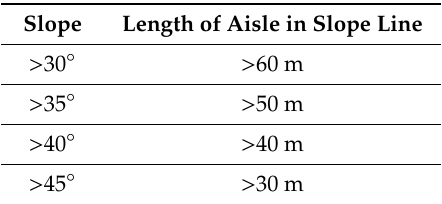
and longer than 60 m can cause